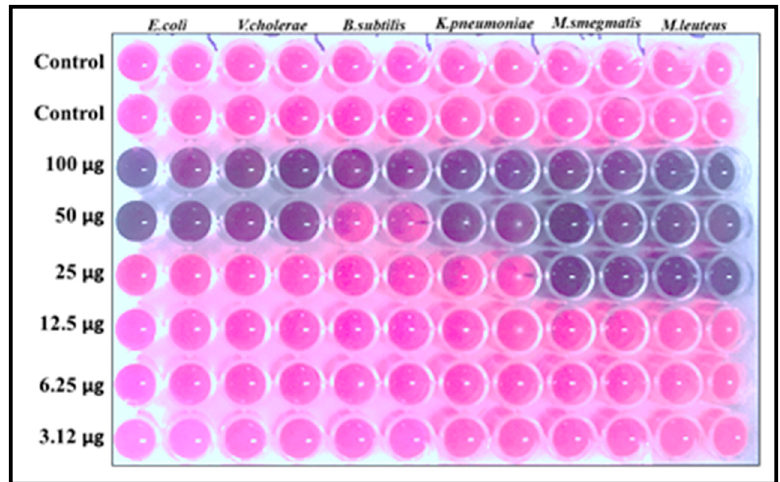
Figure 8. MIC values were confirmed by Resazurin dye assay.